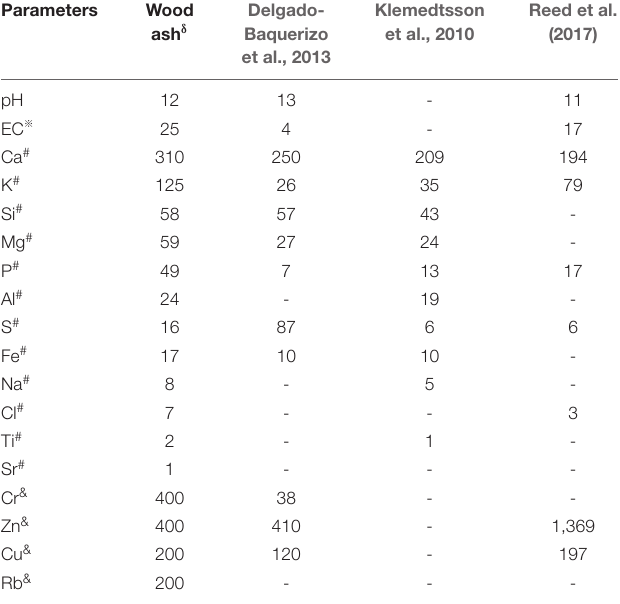
TABLE 1 | Elemental composition of the wood ash used in this study and those from other